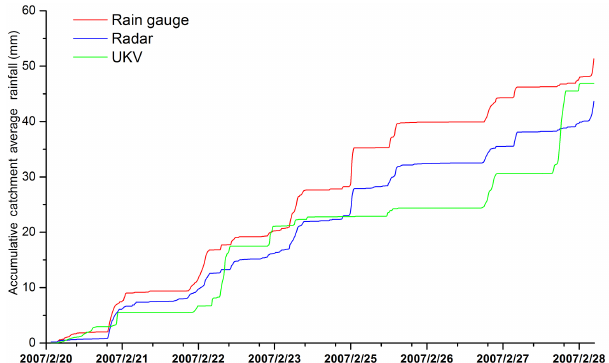
Figure 7. The comparison of accumulative catchment average rain- fall (event February 2007).